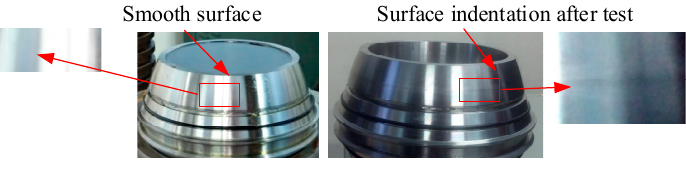
Figure 11. Indentations comparison. Table 2. Comparison of the sealing width of the experimental and analytical